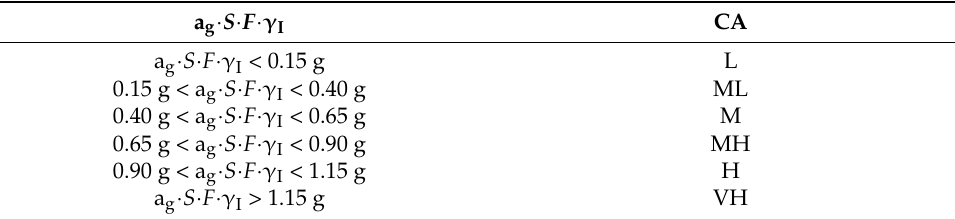
Table 5. Class of attention based on the hazard and exposure.